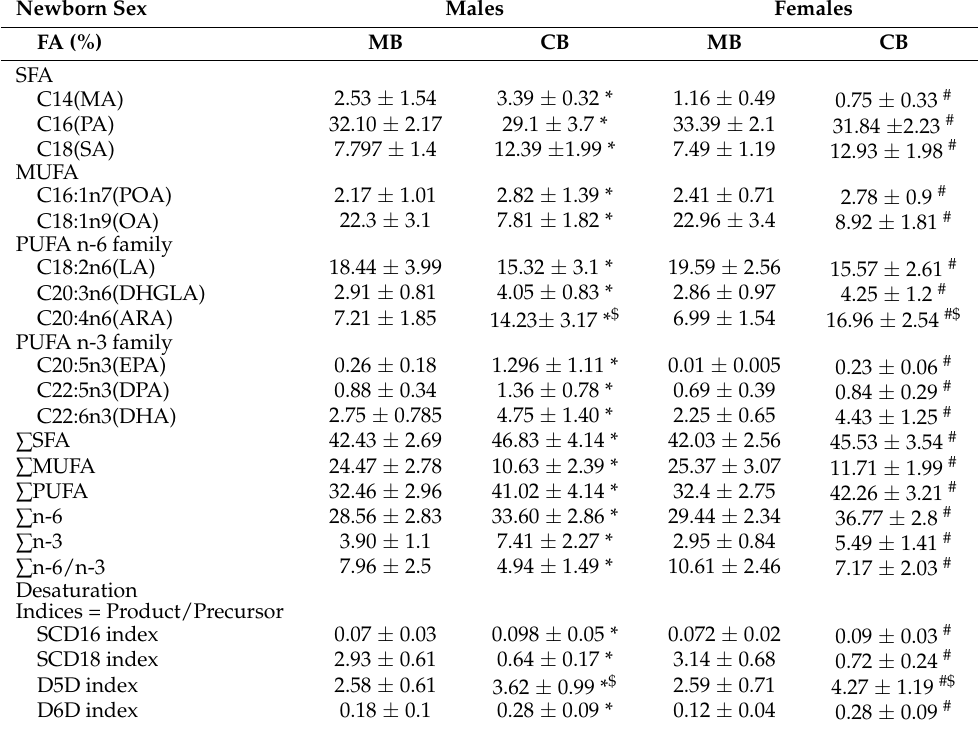
Table 2. Fatty acid status (%) of plasma glycerophospholipids in maternal and umbilical cord